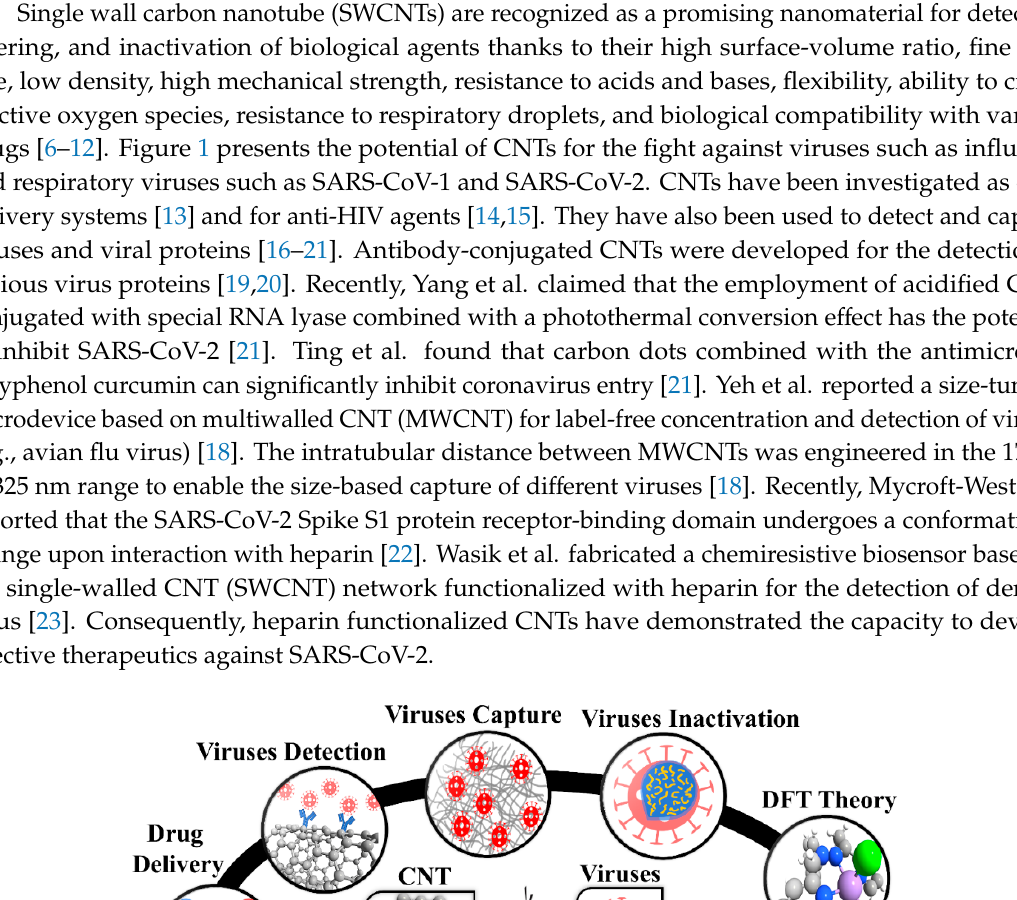
Figure 2. ( a ) Optimized structure of a pristine (8,0) single ‐ wall carbon nanotube (SWCNT) and ( b ) its corresponding energy band structure, showing semiconducting behavior with an energy bandgap of 0.643 eV. The dotted green line indicates the Fermi level, which is set to zero. Different adsorption sites on an SWCNT (Ho: hollow, A: axial, Z: zigzag, and T: top). ( c ) The optimized molecular structure of Hydrogen peroxide (H 2 O 2 ). ( d ) The most stable adsorption configuration of H 2 O 2 on pristine